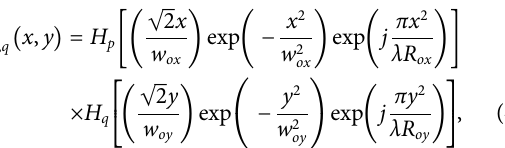
Frontiers in Physics |